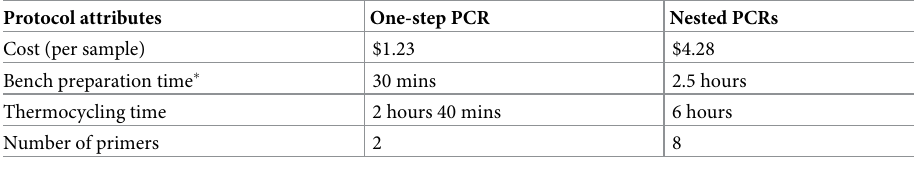
Table 4. Comparison of one-step and nested PCR protocol